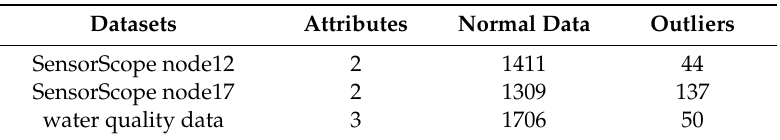
Table 2. Experimental